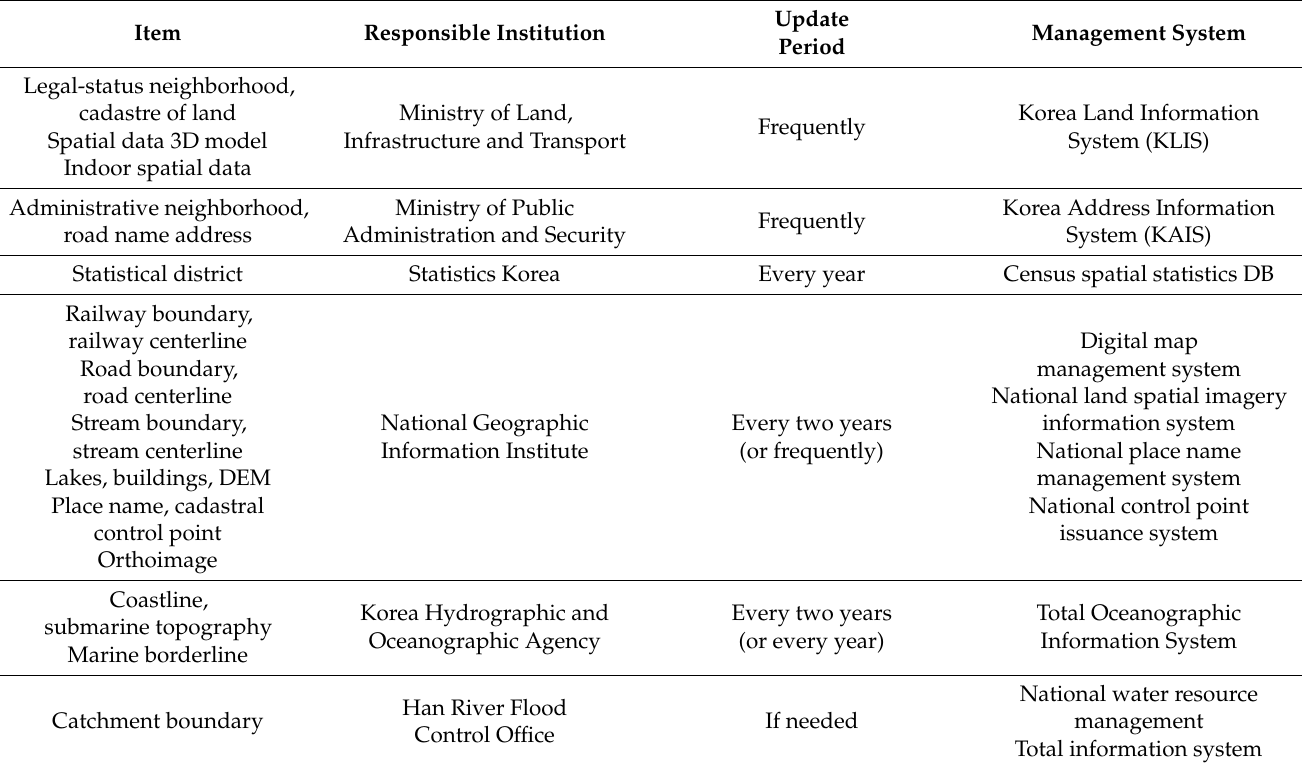
Table 4. Current status of update system of fundamental spatial